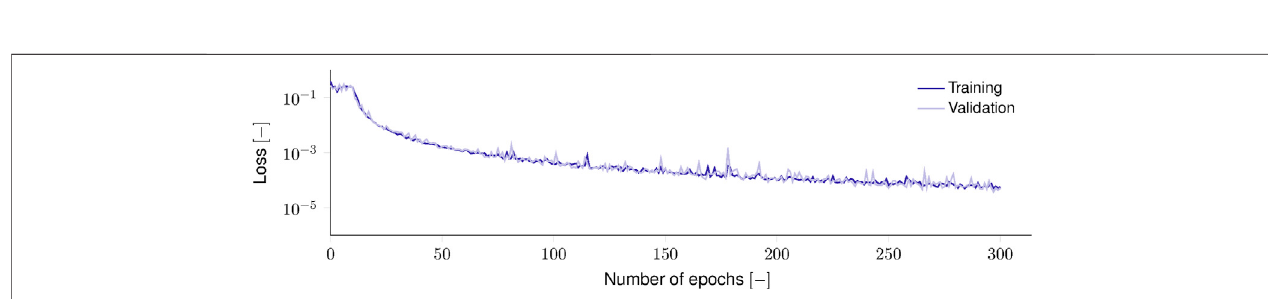
FIGURE8| Threerandomlyselectedstress-stretchcurvesforhyperelasticconstitutivebehavior.Thedata-drivenconstitutivemodelexactlymatchesthereference solution.